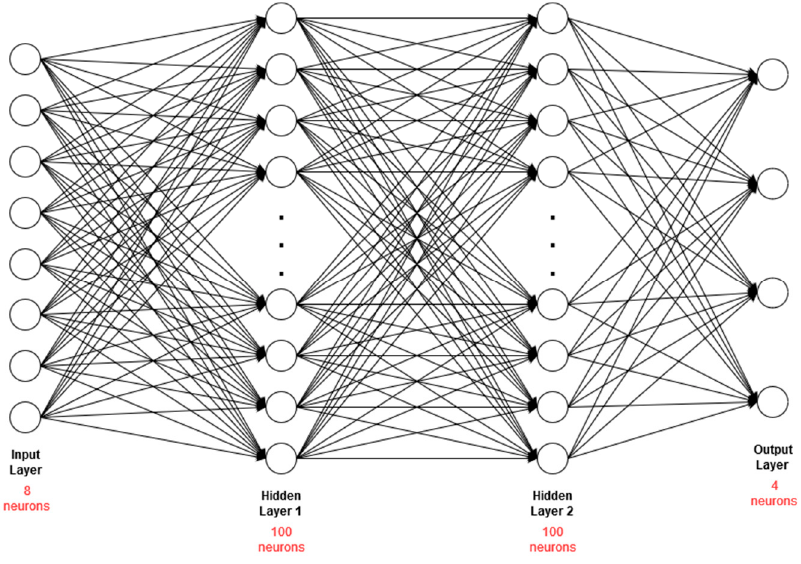
Figure 7. Structure of the neural network built.